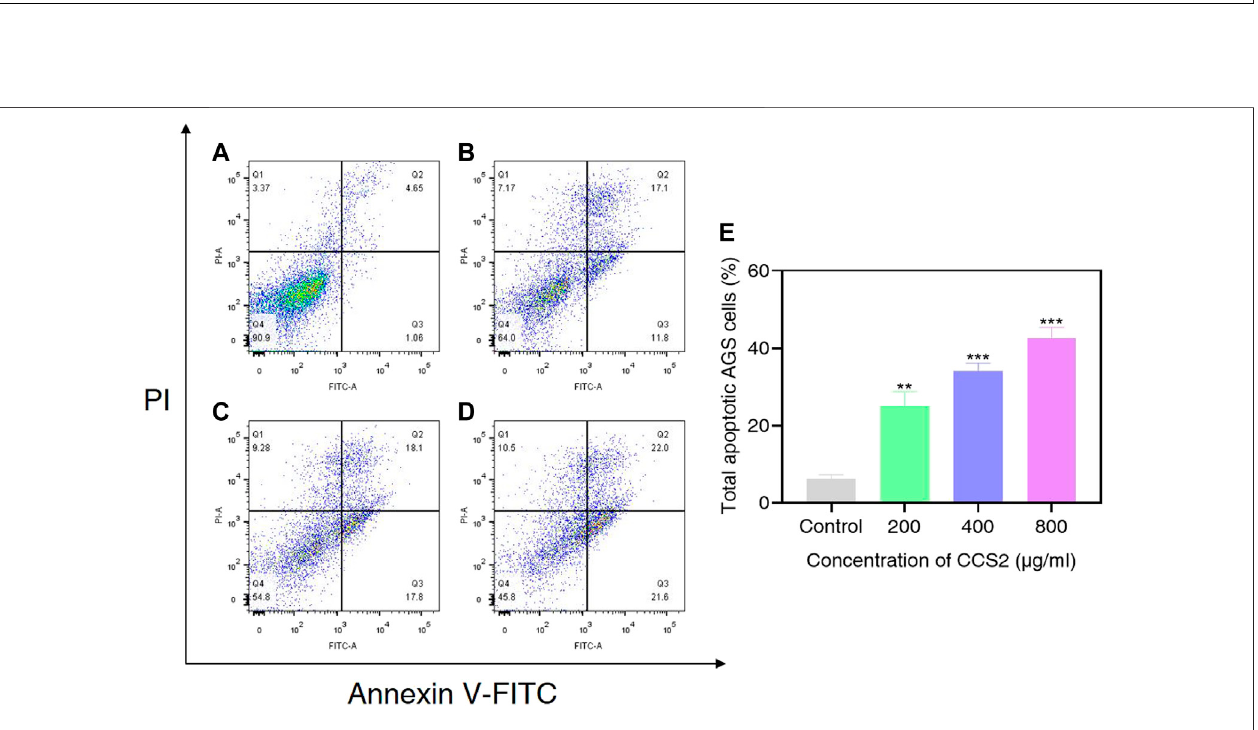
The effects of different doses of CCS2 on the morphology of cancer cell lines were observed ( Figure 3 ). The control groups grew well on the surface of the cell culture dish, whereas the sizes of cancer cells decreased and the cells became rounded, contracted, loosely arranged and poorly adhered with